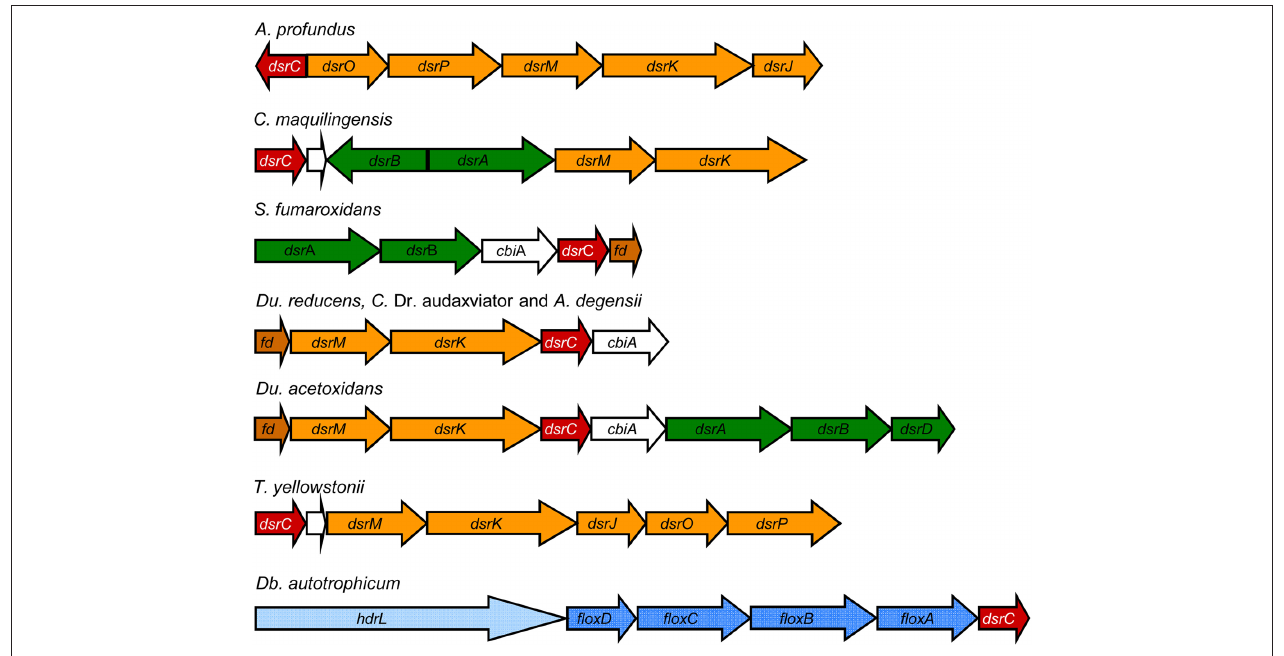
FiguRE 3 | Examples of neighborhood gene organization of the dsrC